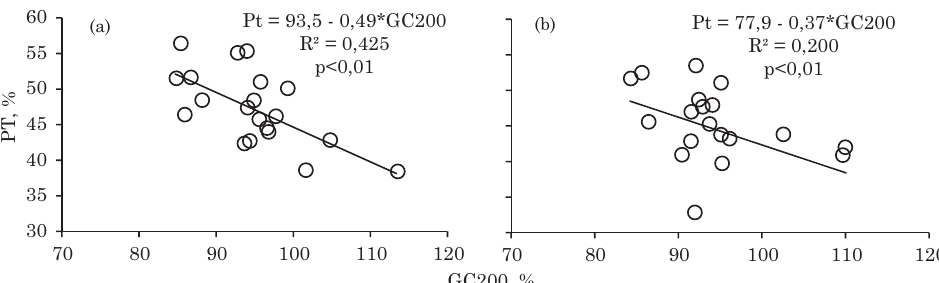
Figura 2. Relação entre porosidade total (Pt) e grau de compactação (GC200) de um solo construído sob diferentes plantas de cobertura nas camadas de 0,00-0,05 m (a) e 0,10-0,15 m (b), em área de mineração de